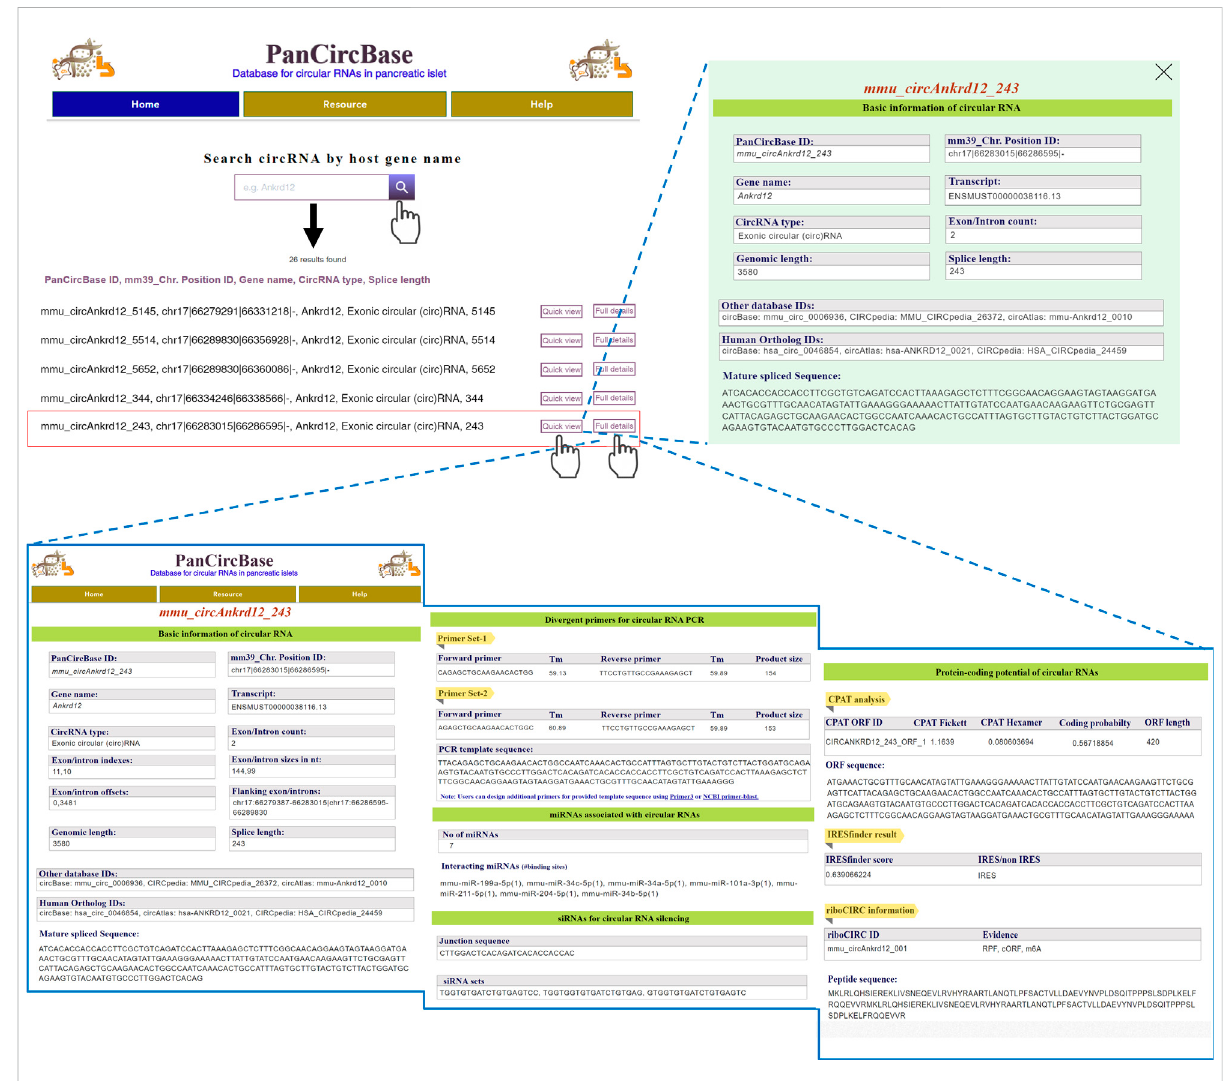
FIGURE 3 Overview of PanCircBase web interface. Users can search by the host gene symbol “ Ankrd12, ” The search results show all the circRNAs originating from the Ankrd12 gene. When users go to “ Quick view ” , PanCircBase opens a new window with the basic information on selected circRNA, and clicking on the “ Full details ” option opens a new page with complete details of selected circRNA, including circRNA annotation, PCR primers, siRNAs, target miRNAs, and possible protein-coding ability of the